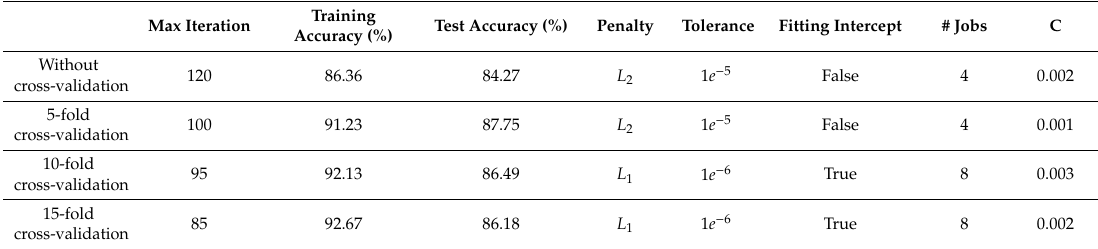
Table 4. Performance comparison of logistic regression (LR) on local intrinsic dimensionality (LID) scores. The solver for this LR classifier is